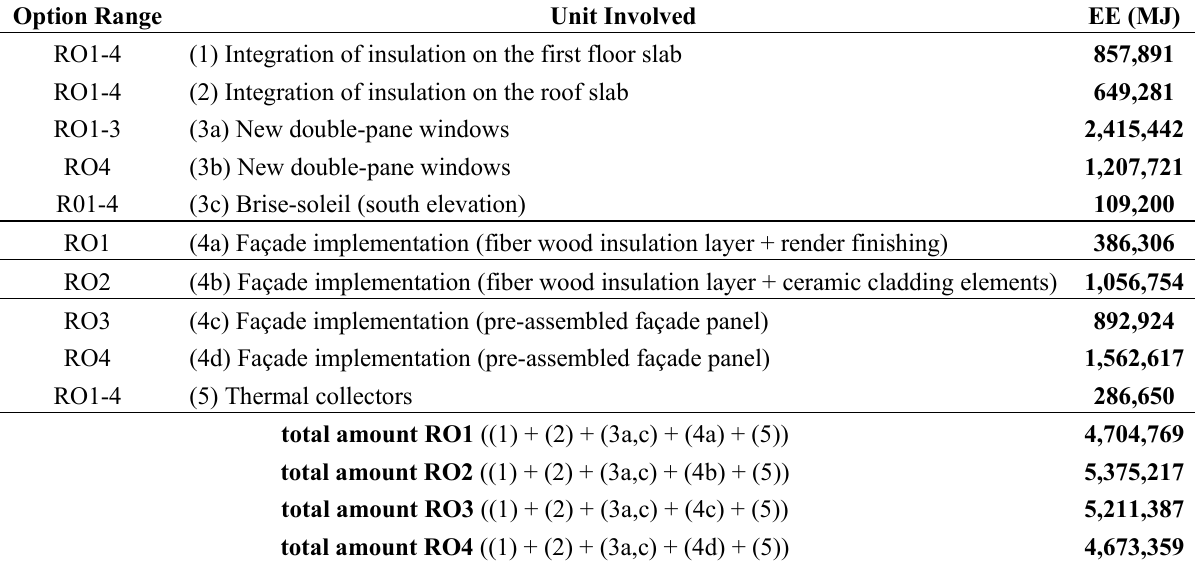
Table 5. Embodied Energy (EE) per considered units and total amount per